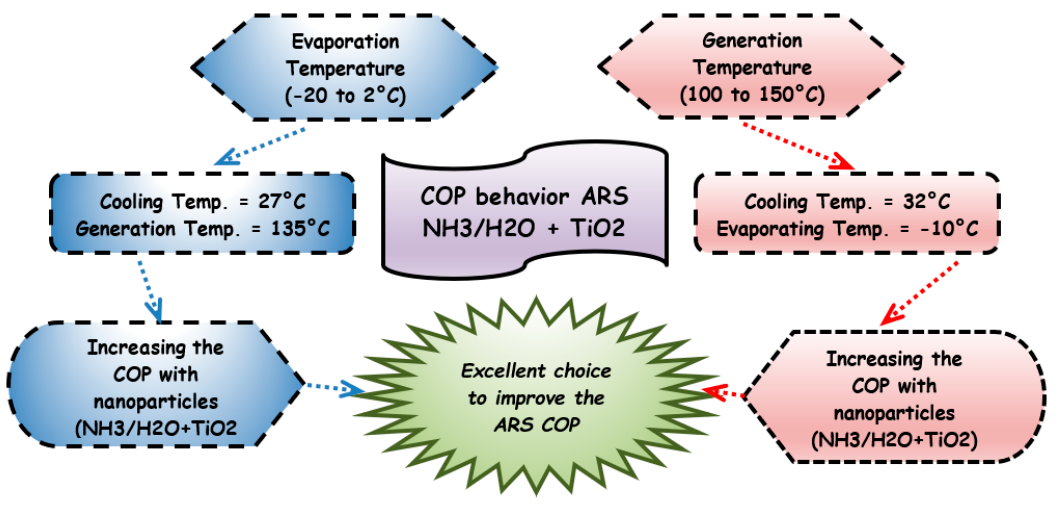
Figure 11. COP behavior of the absorption systems with different mass fractions of TiO 2 nanoparticles under different evaporation and generation temperatures.